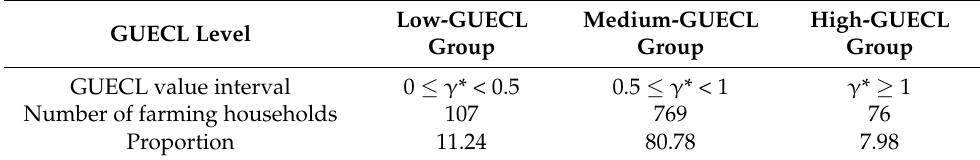
Table 2. Distribution of the GUECL of farming households. GUECL